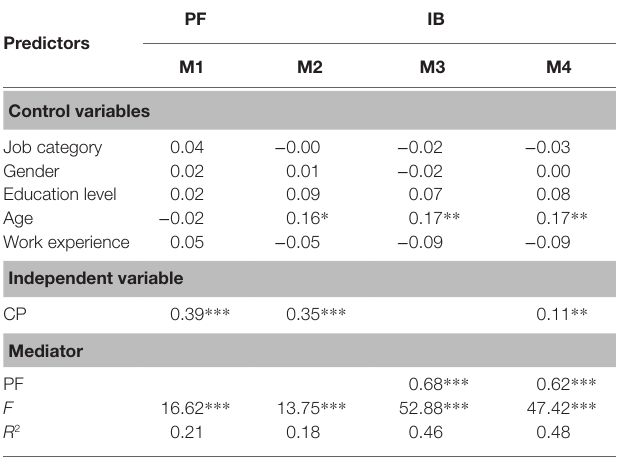
TABLE 3 | Hierarchical regression analysis.